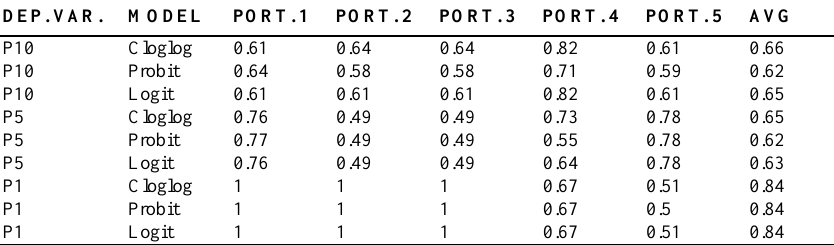
Table 15. Results for the CROC criterion analysis for the portfolios. Out-of- sample analysis DEP. VAR.